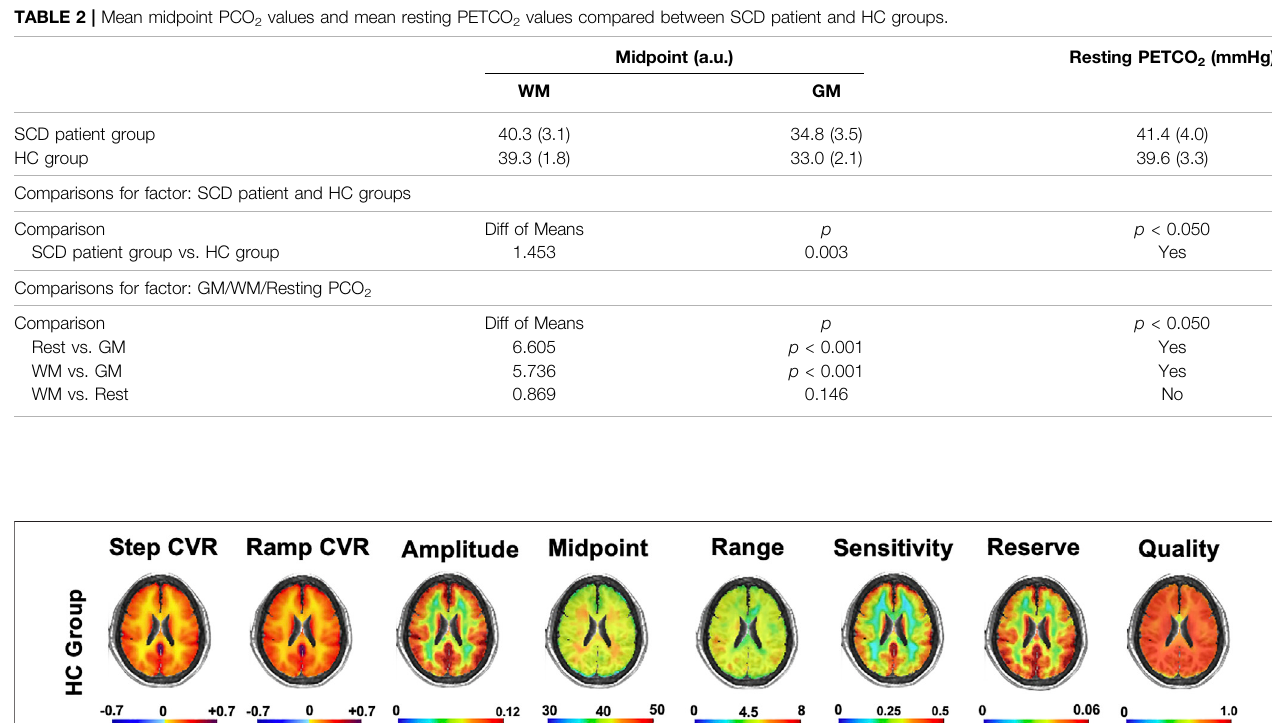
TABLE 2 | Mean midpoint PCO 2 values and mean resting PETCO 2 values compared between SCD patient and HC groups.